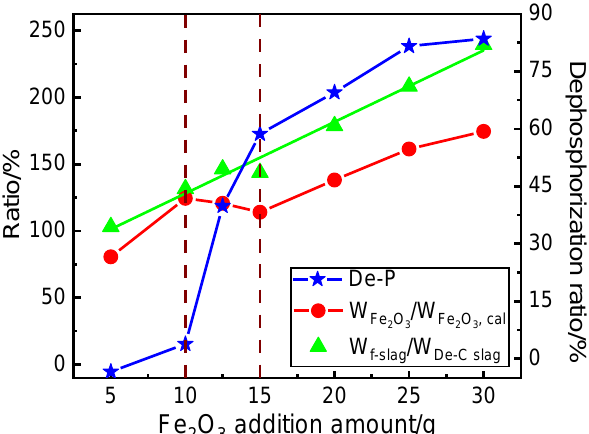
Figure 13. Changes in the ratios of the Fe 2 O 3 addition amount to theoretical calculation consumption, the amount of final dephosphorization slag to the addition amount of decarburization slag as well as the dephosphorization ratio with the Fe 2 O 3 addition amount.